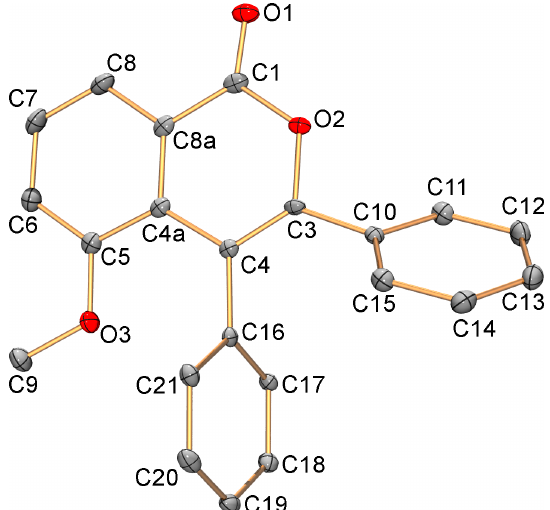
Figure 1. Structure of compound 3aa (one of two symmetry-independent molecules). Ellipsoids are shown at the 50% level. Hydrogen atoms are omitted for clarity. Selected bond lengths (Å) for the first/second symmetry-independent species are as follows: C1 − O1 1.206(1)/1.208(3), C1 − O2 1.368(3)/1.370(3), C3 − O2 1.387(3)/1.389(3), C5 − O3 1.360(3)/1.356(3), C1 − C8a 1.459(4)/1.454(4), C3 − C4 1.336(4)/1.346(4), C4 − C4a 1.465(4)/1.460(4), C4a − C8a 1.400(4)/1.408(4), C4a − C5 1.412(4)/1.419(4),